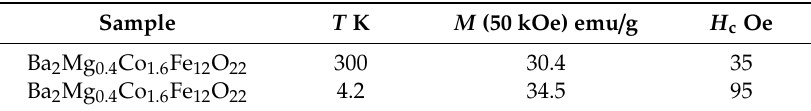
Figure 3. Hysteresis curves ( a ) at 4.2 K and ( b ) 300 K. The insets in ( a ) and ( b ) show expanded view of the narrow magnetic hysteresis loops up to 3 kOe; ( c ) shows the initial magnetization curves at 4.2 K and 300 K. Table 2. Magnetic properties of Ba 2 Mg 0.4 Co 1.6 Fe 12 O 22 .